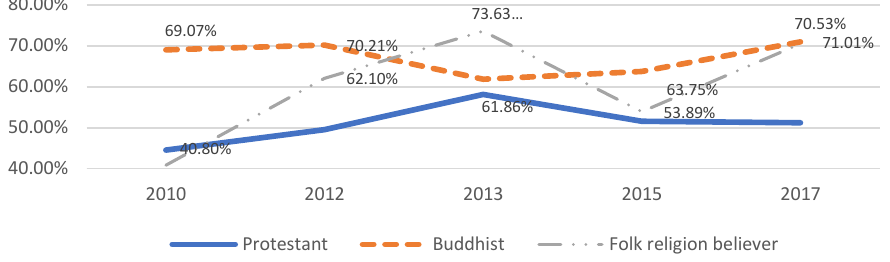
Figure 1. Distribution of religious believers in cities.